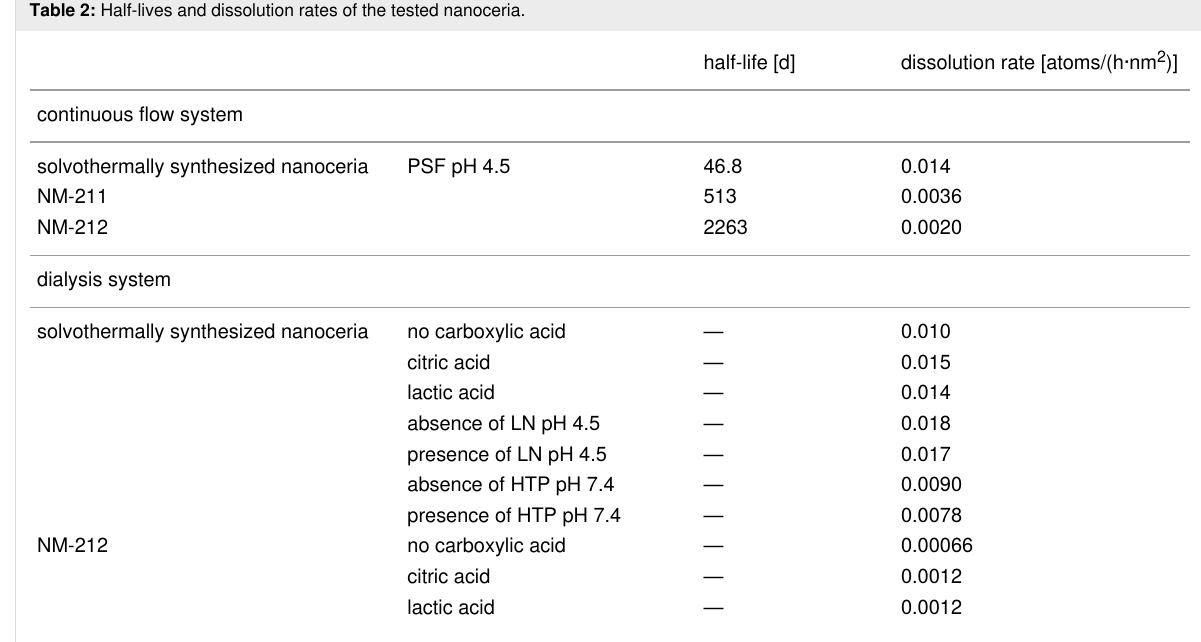
half-life [d] dissolution rate [atoms/(h·nm 2 )]